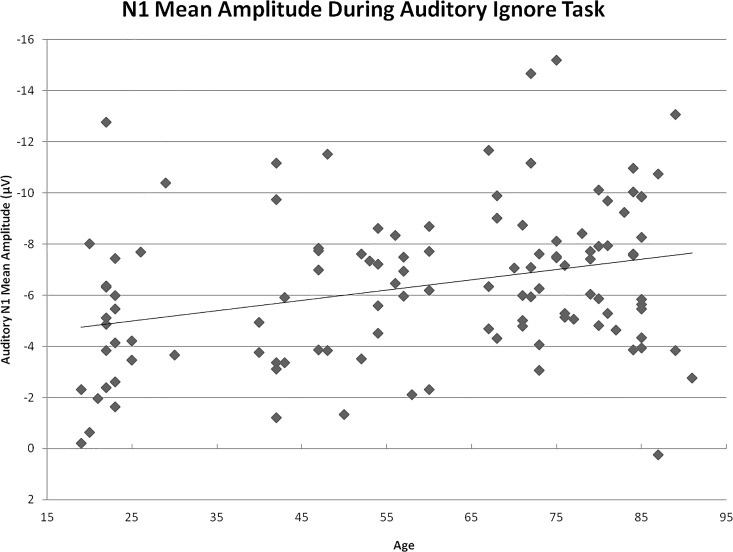
Scatterplot of N1 mean amplitude.Mean amplitude calculated across auditory ignore tasks (low load and high load) and stimulus types. Regression: N1 amplitude (μV) = -3.987–.040 (age).